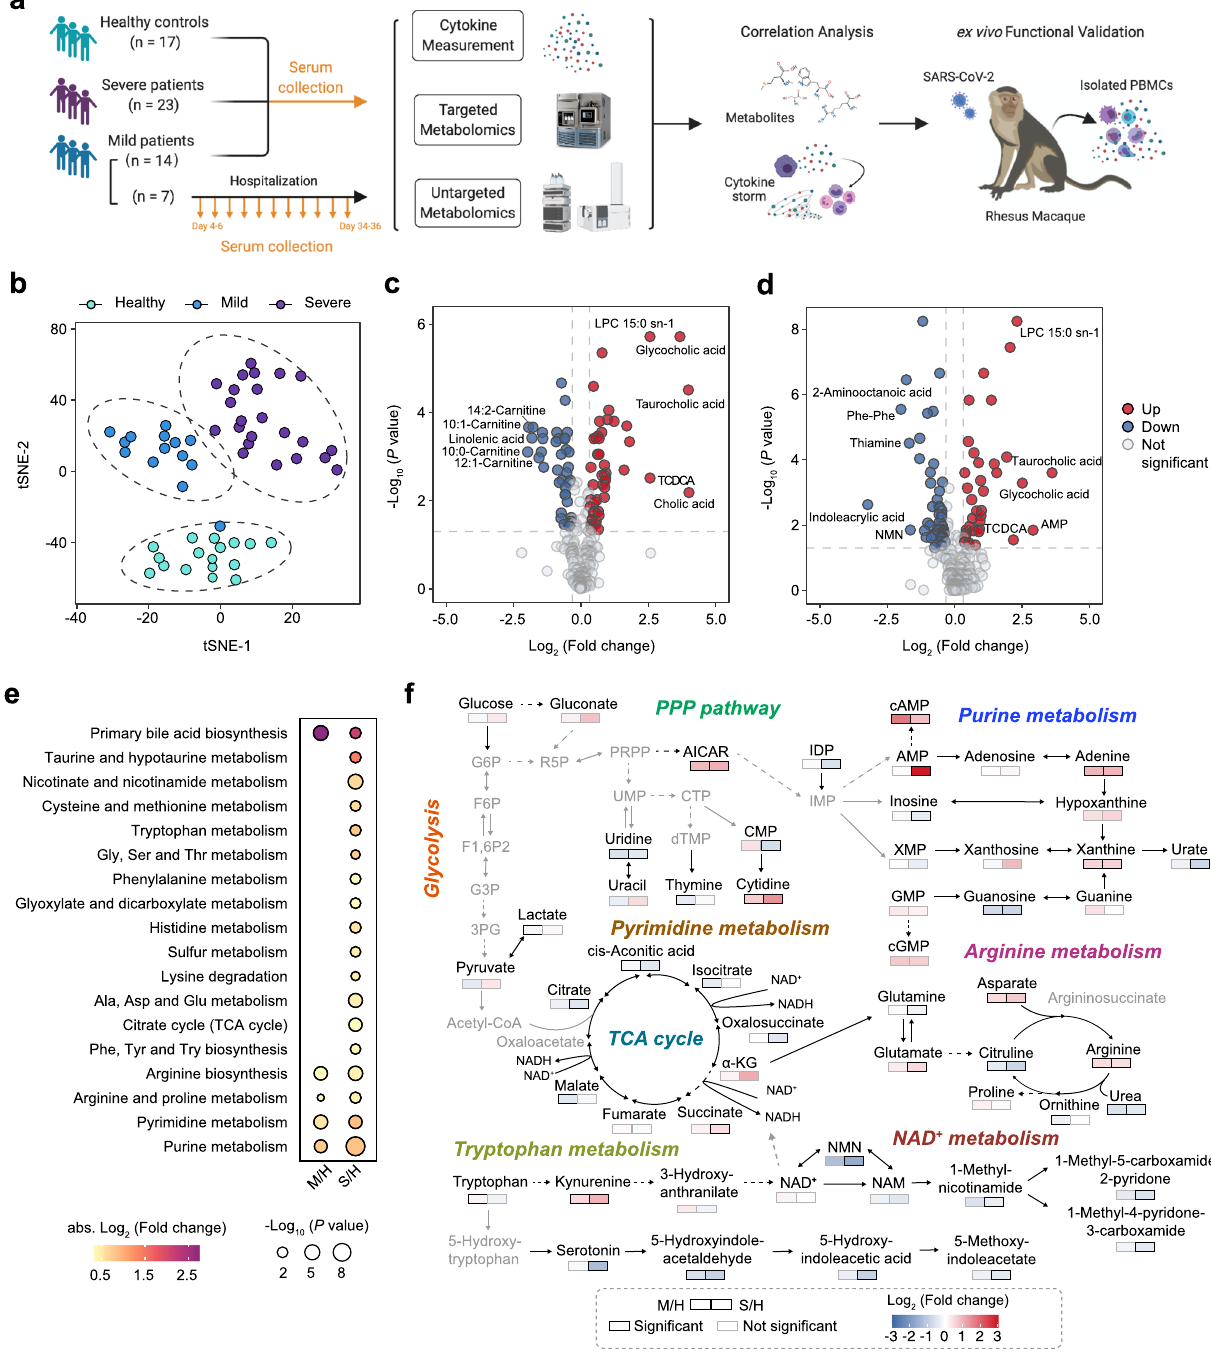
Fig. 1 Study design and metabolic pro fi ling in serum samples from mild and severe COVID-19 patients. a Overview of cohort (including 21 mild patients, 23 severe COVID-19 patients, and 17 healthy controls) and the study design. b t -SNE plot distributed healthy controls ( n = 17), mild patients ( n = 14), and severe patients ( n = 23) according to serum metabolites detected from targeted and untargeted metabolomics. c, d Volcano plots comparing serum metabolites of mild ( c ) or severe ( d ) patients with healthy controls. Signi fi cantly altered metabolites are highlighted in red (increased) and blue (decreased). The top 5 metabolites that signi fi cantly increased or decreased are marked with text. Two-sided Mann-Whitney U test followed by Benjamini- Hochberg (BH) multiple comparison test with FDR < 0.05 and fold change >1.25 or <0.8. e KEGG metabolic pathways enriched by signi fi cantly changed serum metabolites in mild ( c ) and severe ( d ) patients. One-sided Fisher ’ s exact test followed by BH multiple comparison test with FDR < 0.1. f Schematic depicting the key disturbed metabolic pathways in response to SARS-CoV-2 infection. Gray nodes represent metabolites that were not tested. Metabolite alterations are represented by color intensity, and borders are color-coded by statistical signi fi cance.